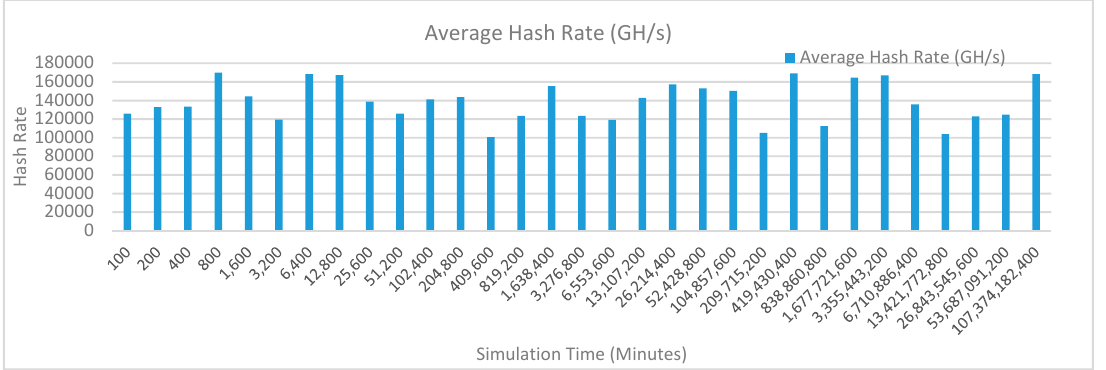
Figure 26. Average hash rate analysis (with IoT, edge, fog, and cloud).